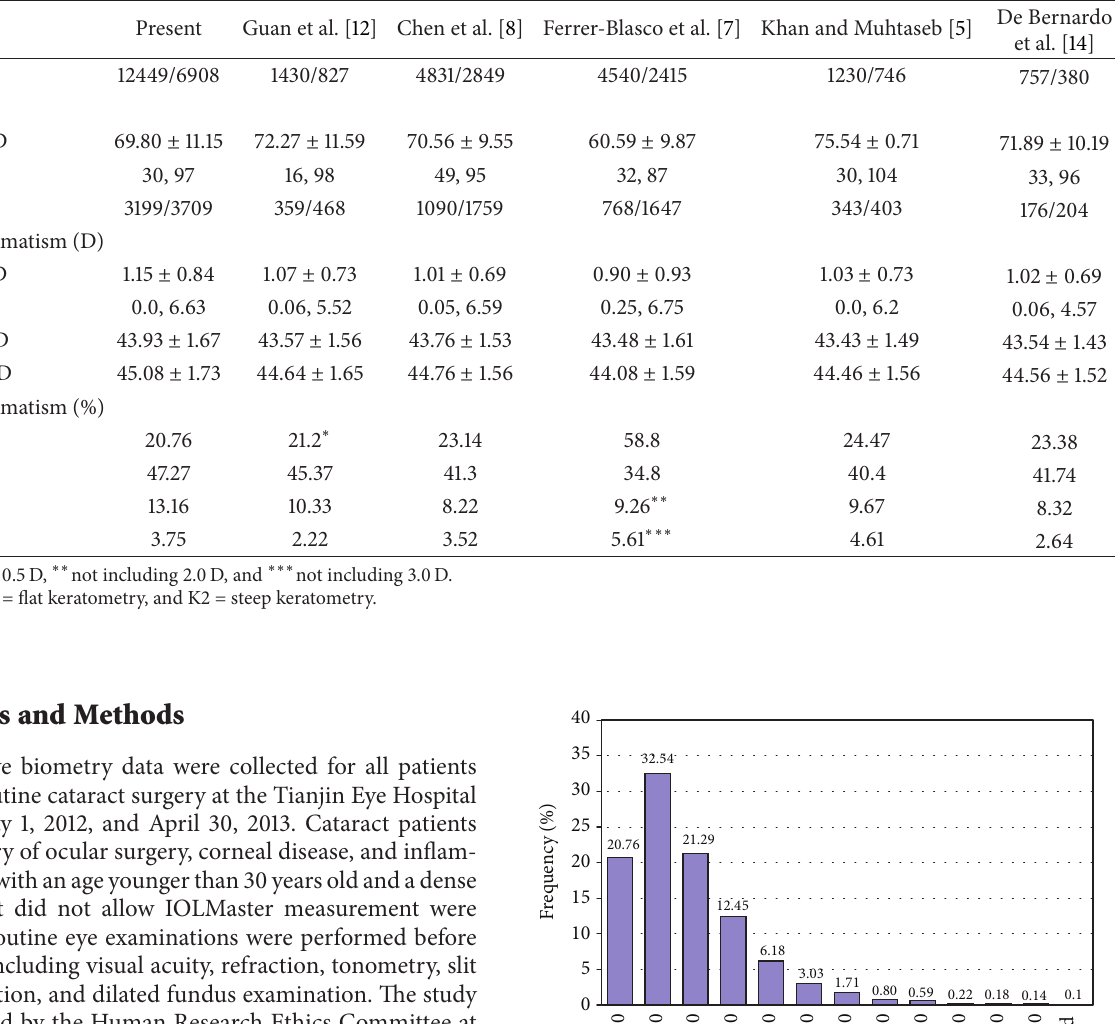
Table 1: Patient demographics compared with 5 other published studies.